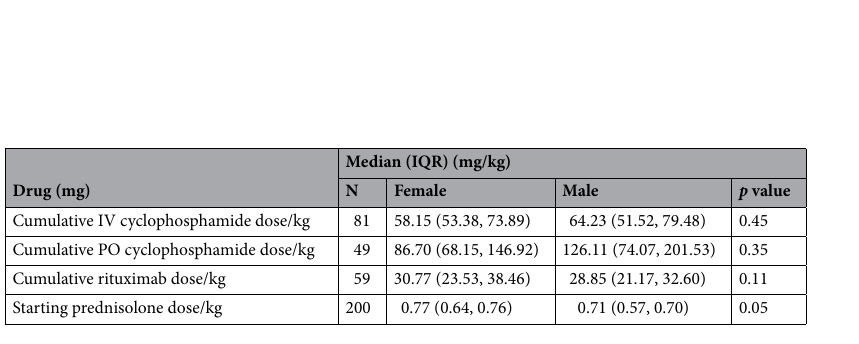
Table 4. Induction immunosuppression dose per kilogram, stratified by gender. Milligram (mg), kilogram (kg), intravenous (IV), oral